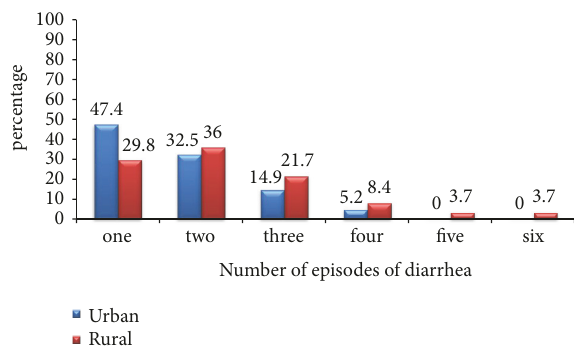
Figure 1: Number of episodes of diarrhea per one year among under-five children in urban and rural resident of Doba woreda, Ethiopia, 2017.